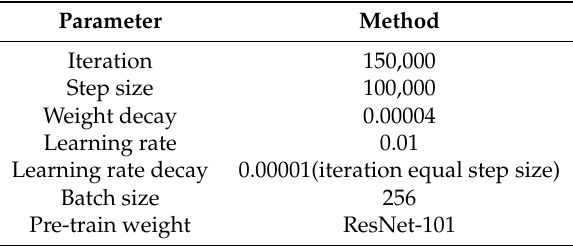
Table 1. Training parameters of Faster R-CNN.